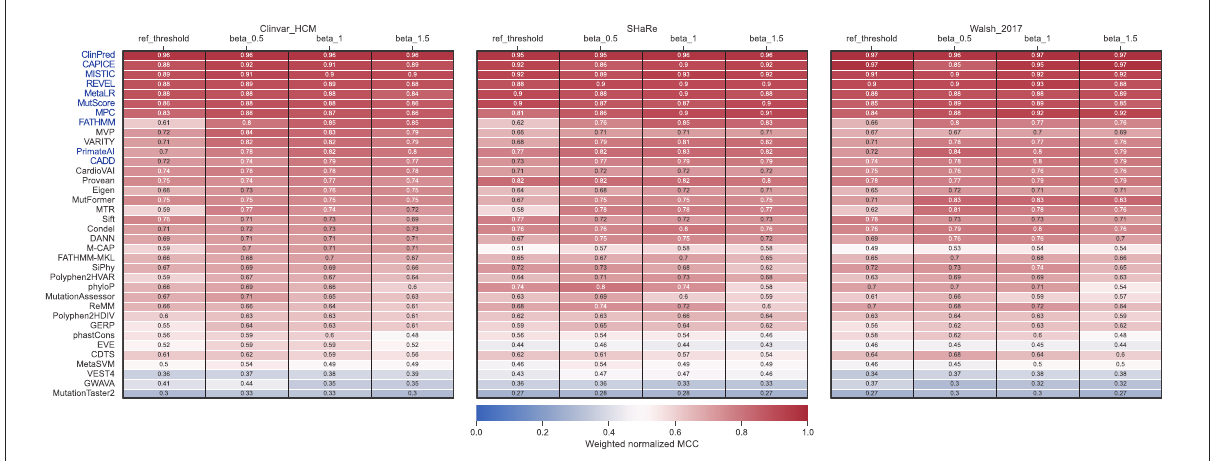
FIGURE5 Performance of prediction tools using adjusted thresholds on each dataset (ClinVar, SHaRe, and Walsh_2017). Optimized thresholds at Beta to false positives and false negatives. Optimized thresholds at Beta pathogenic). Tools highlighted in blue were selected as the best by averaging the ranks between the three datasets.